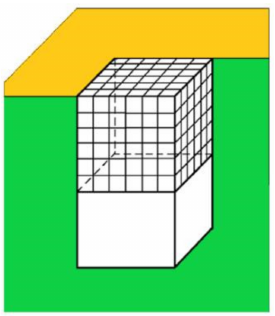
Figure 4. Cross-section (green) of a pore with a cubic crystal that just reaches the pore opening; the surface of the porous material is in gold. The protein crystal is in equilibrium with the solution trapped beneath